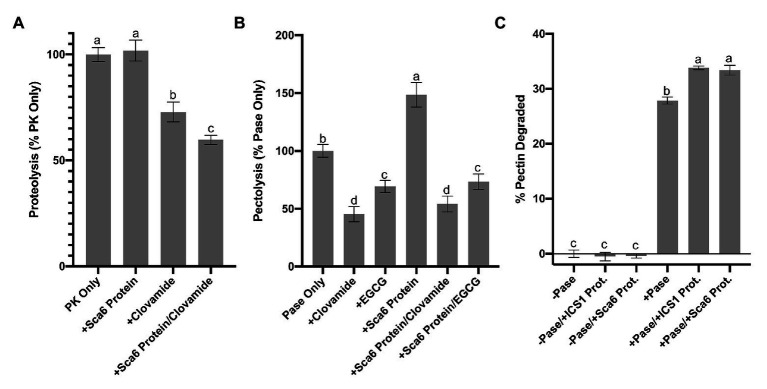
Enzyme inhibition by clovamide and effect of cacao stage C leaf protein pectinase activity. (A) Proteolysis inhibiton by clovamide. “PK” = proteinase K. PK included in all treatments shown, with the addition of ‘Sca6’ protein, clovamide (2 mM), or both. Data represents two experiments (n = 5 from each). (B) Pectolysis inhibition by clovamide. “Pase” = pectinase from A. niger. “EGCG” = epigallocatechin gallate. Pase included in all treatments, with the addition of clovamide (2 mM), EGCG (2 mM), ‘Sca6’ stage C leaf protein, or ‘Sca6’ protein in combination with either phenolic compound. Data represents two experiments (n = 3 from each). (C) Enhancement of pectinase (A. niger) activity by cacao stage C leaf protein (n = 3). No pectinase (“-Pase”) and pectinase (“+Pase”) with or without addition of ‘ICS1’ or ‘Sca6’ leaf protein. Shared letters mean no difference by Tukey-HSD at p < 0.0001 (A), p < 0.05 (B), or p < 0.0001 (C). Error bars represent standard deviation.